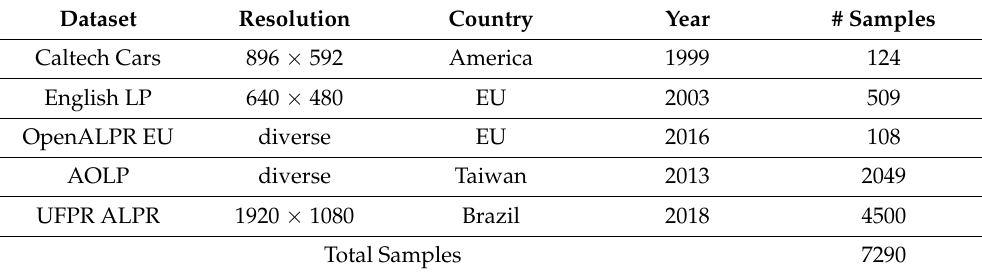
Table 1. An overview of the datasets used in our experiments and its